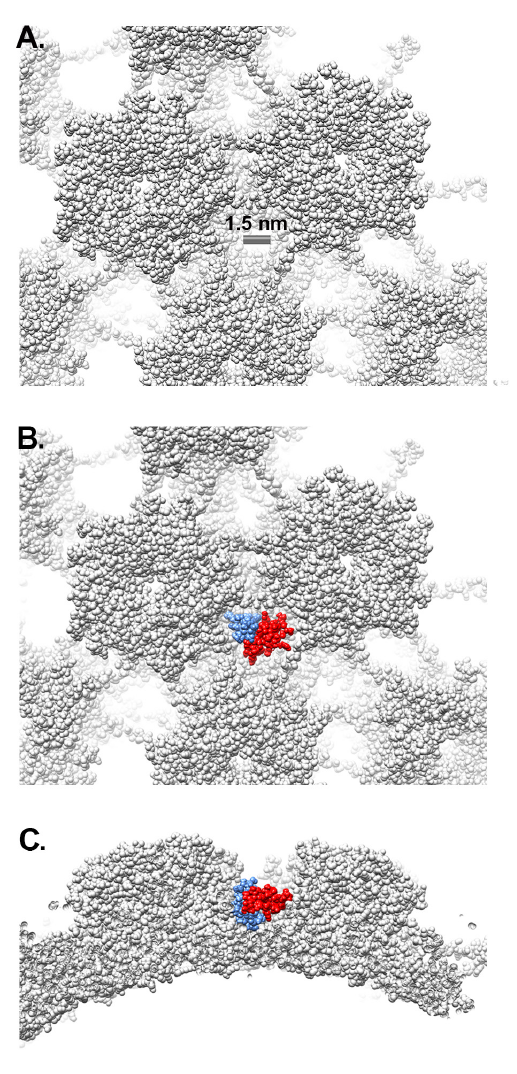
Figure 3. Gaps in the L1 capsid are smaller than HD5. (A) Space-filling representation of the L1 capsid with a scale bar indicating a capsid gap ~1.5 nm in diameter (PDB: 5KEP). (B) Space- filling representation of an HD5 dimer (red and blue) (PDB: 1ZMP, chains A and C) positioned within a depression between L1 pentamers. (C) Side view of panel